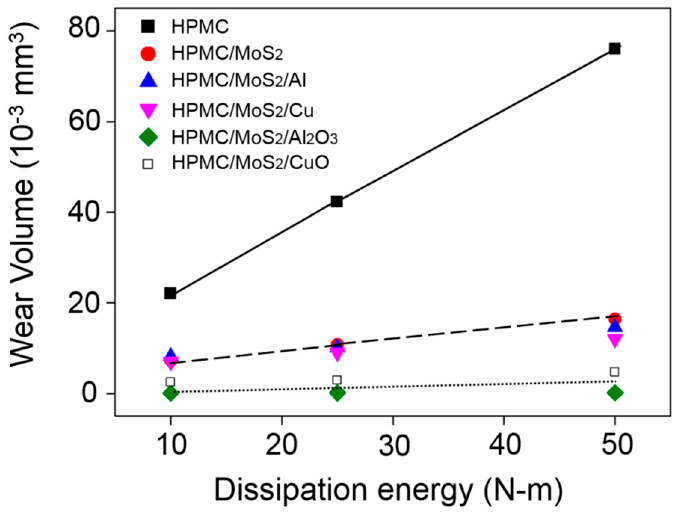
Figure 10. Wear volume and dissipation energy curves of HPMC-based composites (2 wt.% additive).